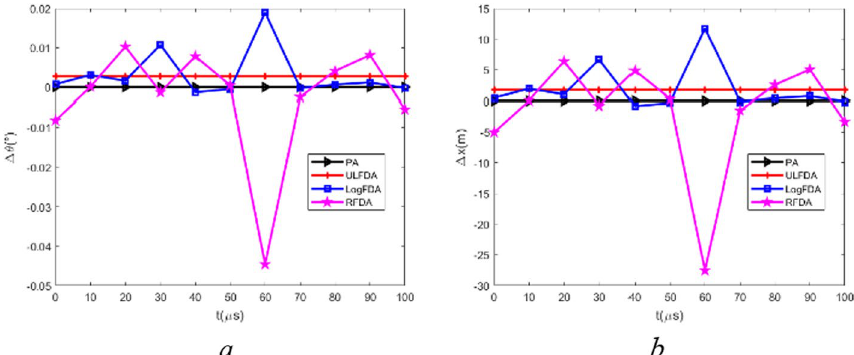
Fig. 7 Estimation error with t . a DOA estimation and b Location estimation